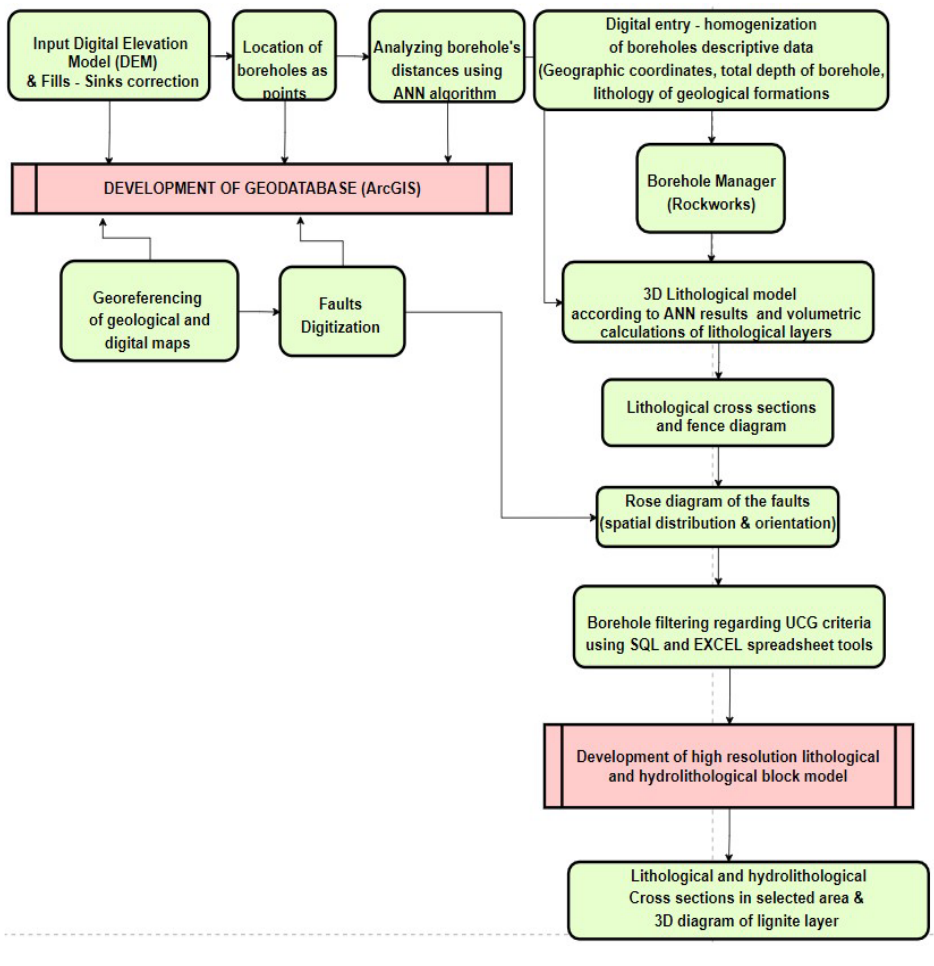
Figure 4. Workflow of the data preparation for the geospatial analysis and creation of the database using various datasets.